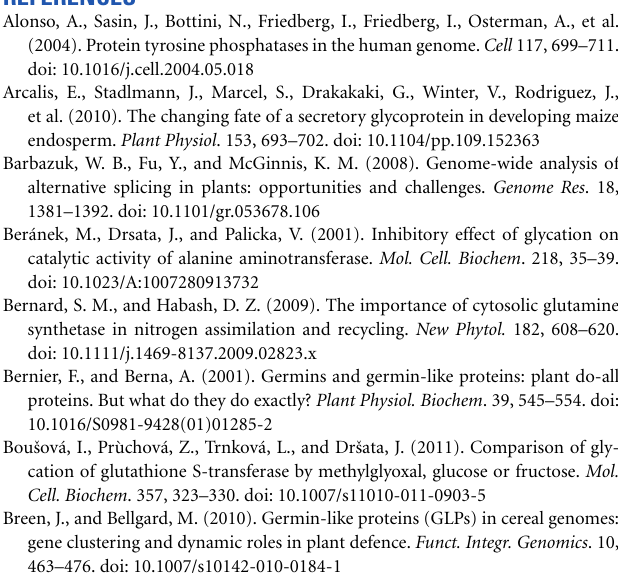
Supplemental Figure 1 | Overview of glycoprotein stain (A,B) vs. total protein stain (C,D) of wild type (A,C) and mutant (B,D). Supplemental Table 1 | Selection of spots to be analyzed by mass spectrometry. Spots in bold showed a significant variation of 20% and were chosen for mass spectrometry. GLY/G and TP stand for glycoproteins and total